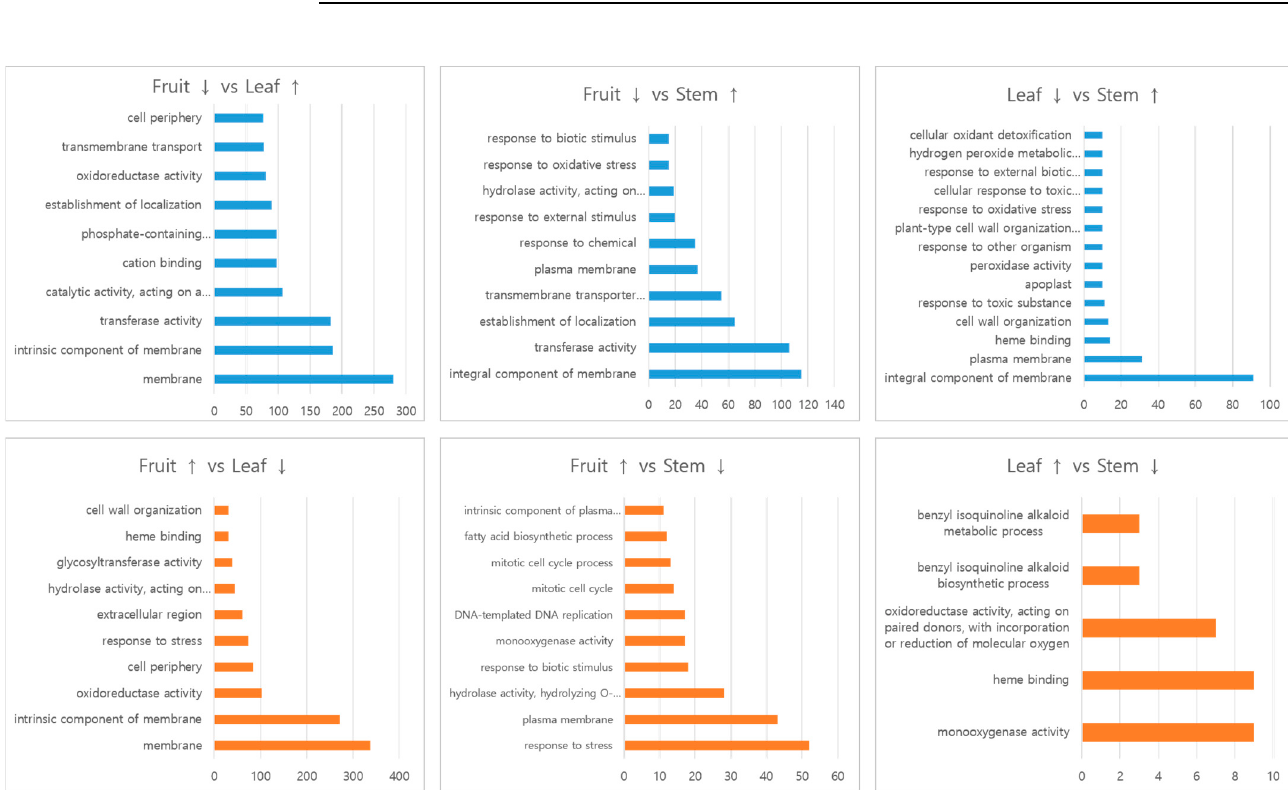
Table 2. Number of up- or down-expressed genes between tissues in vis-à-vis comparison. Fruit vs. Leaf Leaf vs. Stem Fruit vs. Stem Up 761 326